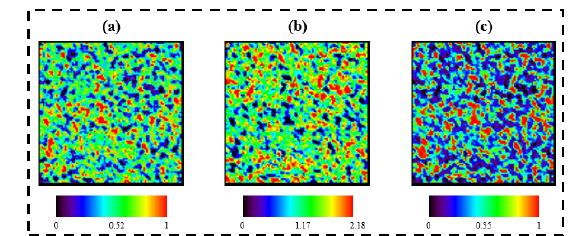
Figure 8. Textural parameters of the retained 3 He. (a) IDM, (b) Entropy, and (c) ASM.